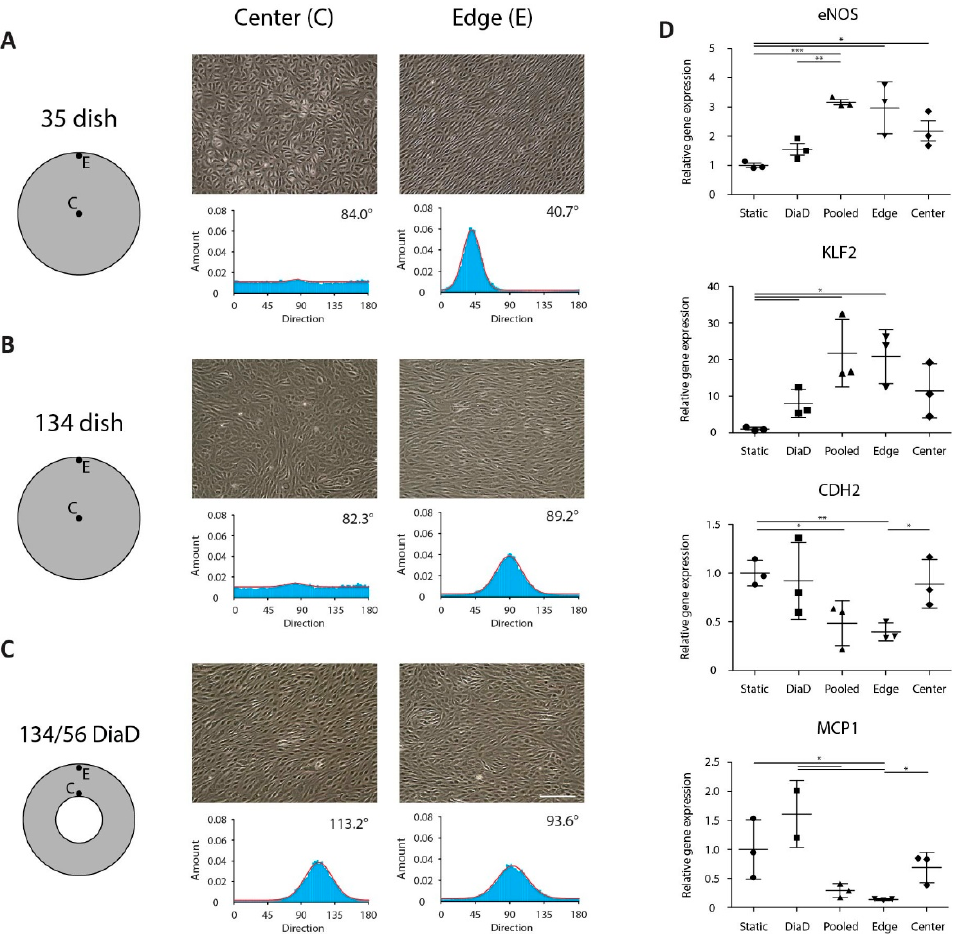
Figure 7. Endothelial cell response to shear stress experienced in the annular dish. ( A – C ) Widefield images of endothelial cells under shear stress at the center or the edge of a standard culture dish or an annular dish. The alignment directionality of the endothelial cells is quantified in the histograms below. Scalebar represents 200 µm. ( D ) Gene expression levels of the shear stress responsive genes eNOS , KLF2 , CDH2 and MCP1 in endothelial cells under static conditions and in different (regions in) culture dishes. All genes demonstrate a response in gene expression in response to shear stress compared to the static controls. One measurement for the dish-in-a-dish (DiaD) group for MCP1 was excluded based on Grubbs’ outlier test. Error bars are defined as the standard deviation. Significance is indicated at * p < 0.05, ** p < 0.01 and *** p < 0.001.